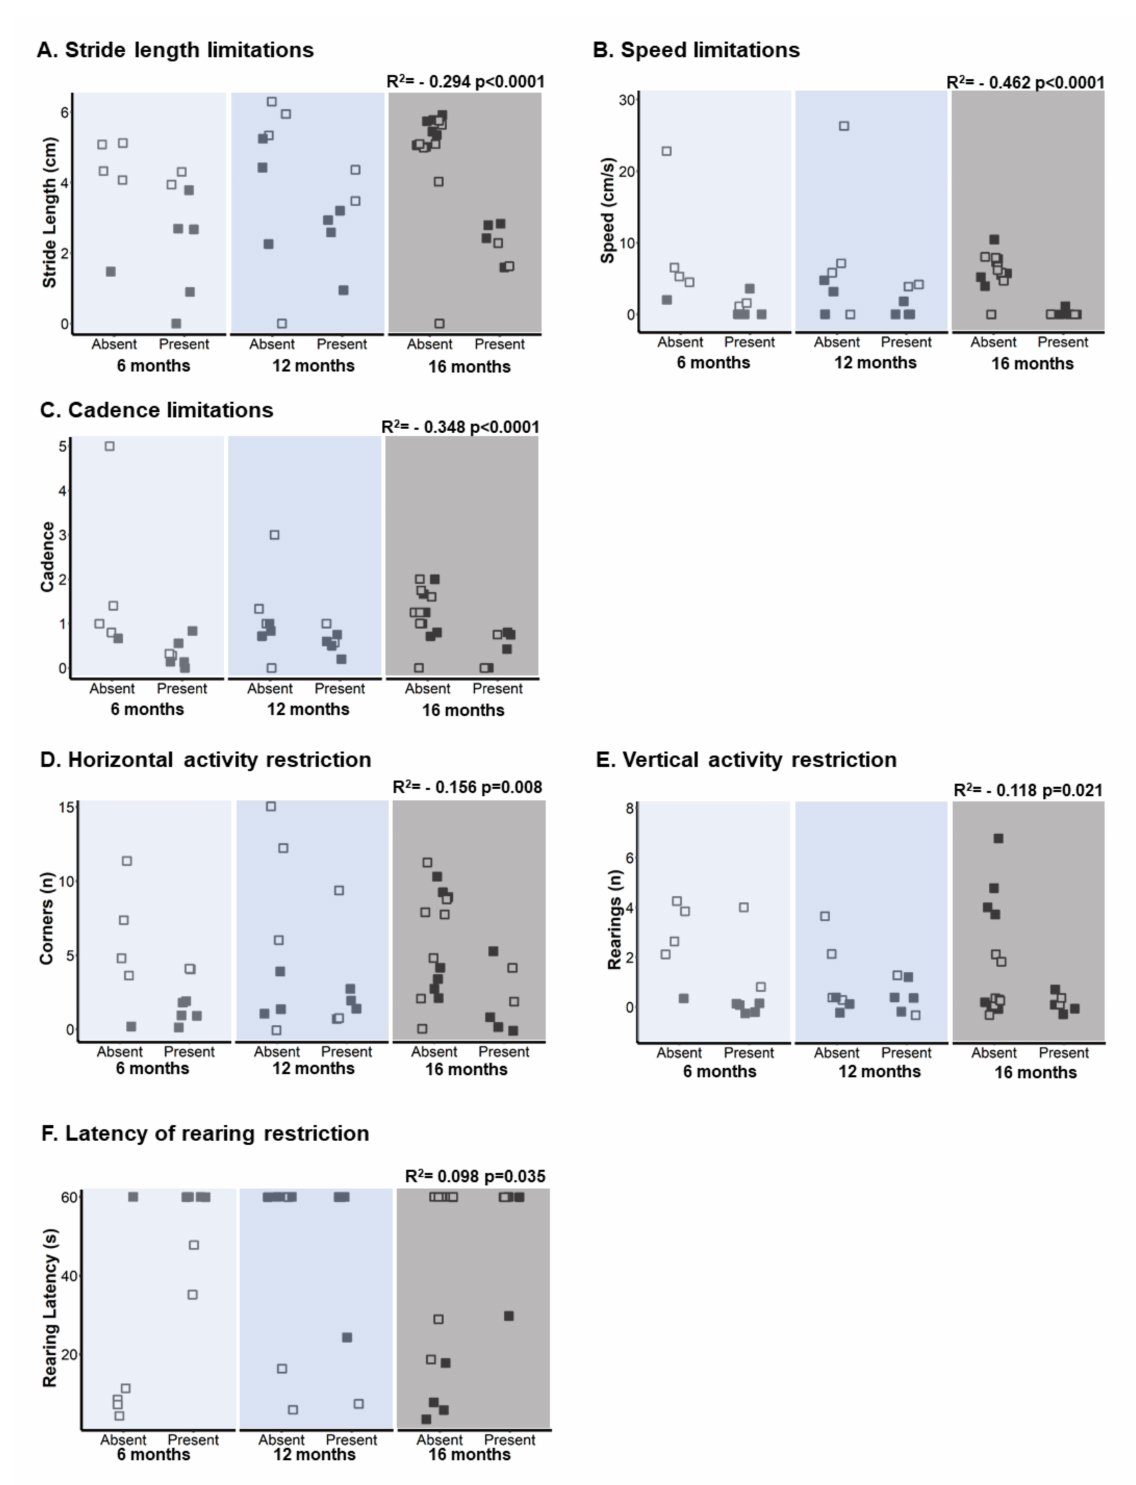
Figure 4. Activity limitations and restrictions of gait and exploration. ( A ) Stride length limitations, ( B ) speed limitations, ( C ) cadence limitations, ( D ) horizontal activity restriction, ( E ) vertical activity restriction, and ( F ) latency of rearing restriction. The NTg group has been represented by a white square and the 3xTg-AD group by a black square. According to the groups under study, it has been defined as “present/absent” the behaviors reported as bizarre gait patterns of each animal. The Point-Biserial Correlation has been applied to determine the relationship between the activity limitation and restriction (presence/absence) with stride length, speed, and cadence and exploration. Statistics: Pearson